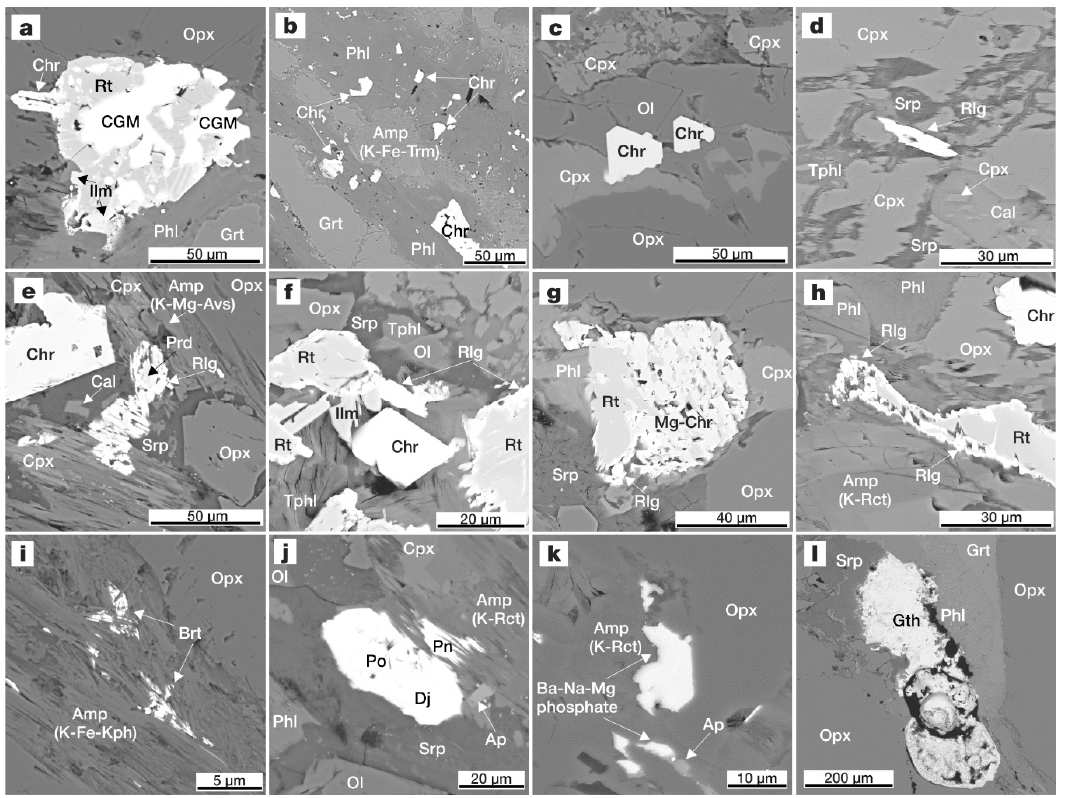
Figure 5. BSE images depicting minerals found in the intergranular space of the orthopyroxenite. ( a ) an inhomogeneous oxide intergrowth consisting of crichtonite-group minerals, rutile, chromite and ilmenite; ( b ) an aggregate composed of Al-rich potassic amphibole, chromite and phlogopite that replaces pre-existing garnet; ( c ) euhedral chromite crystals; ( d–h ) redledgeite occurrences, either as an individual crystal ( d ) or as thin rims on other oxide minerals ( f–h ); ( i ) barite specks associated with Al-poor potassic amphibole; ( j ) a polymineralic sulfide aggregate composed of pentlandite, pyrrhotite and djerfisherite; ( k ) an euhedral crystal of Ba-Na-Mg phosphate associated with apatite and K-richterite; ( l ) a reniform accumulation of goethite. Mineral abbreviations are those described in the Section “Materials and Methods” and Table